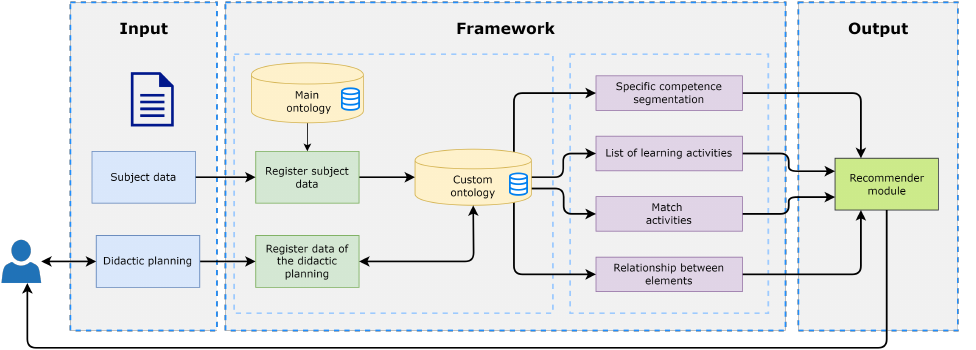
Figure 9. Framework as a feedback